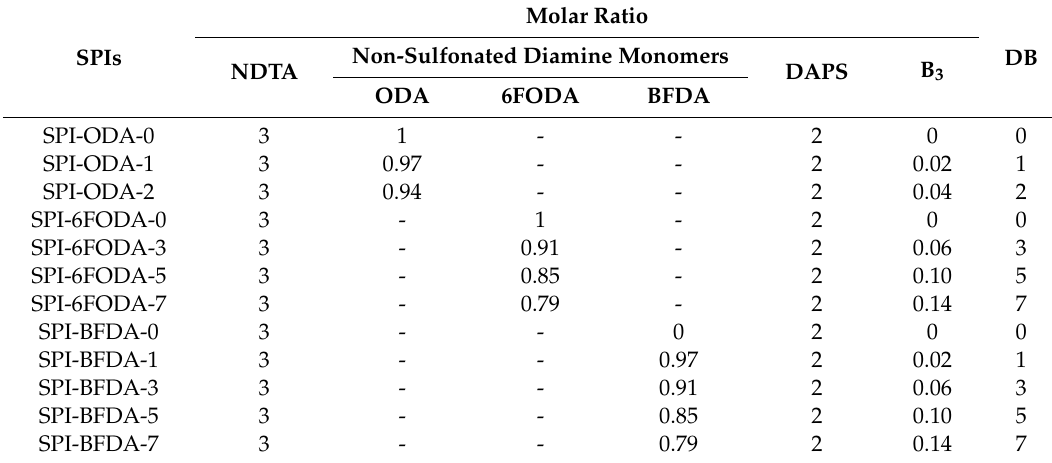
Table 1. The feed ratios and degree of branching (DB).